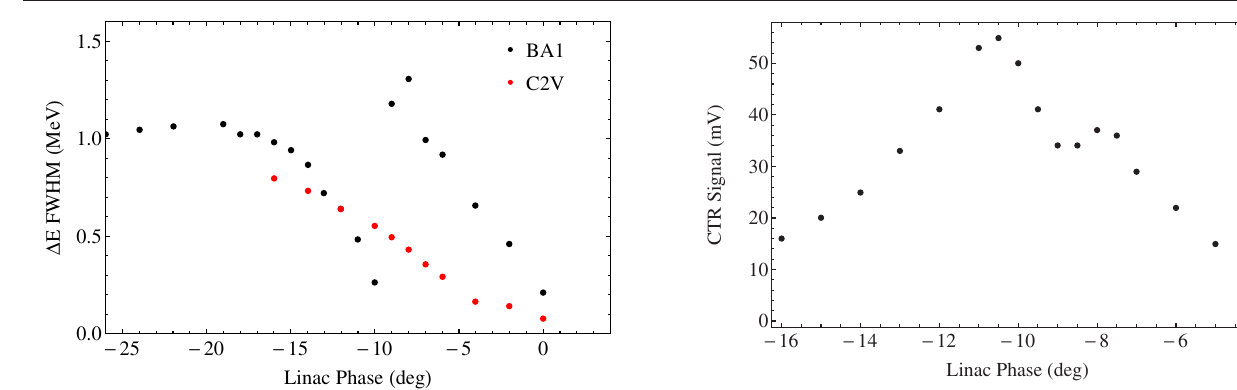
FIG. 39. FWHM energy spread as a function of the linac off- crest phase: Red dots, after the linac as measured in the S-bend spectrometer (C2V); black dots, as measured in the BA1 spectrometer. The legend refers to YAG screens located after the dipole magnets at these two locations.